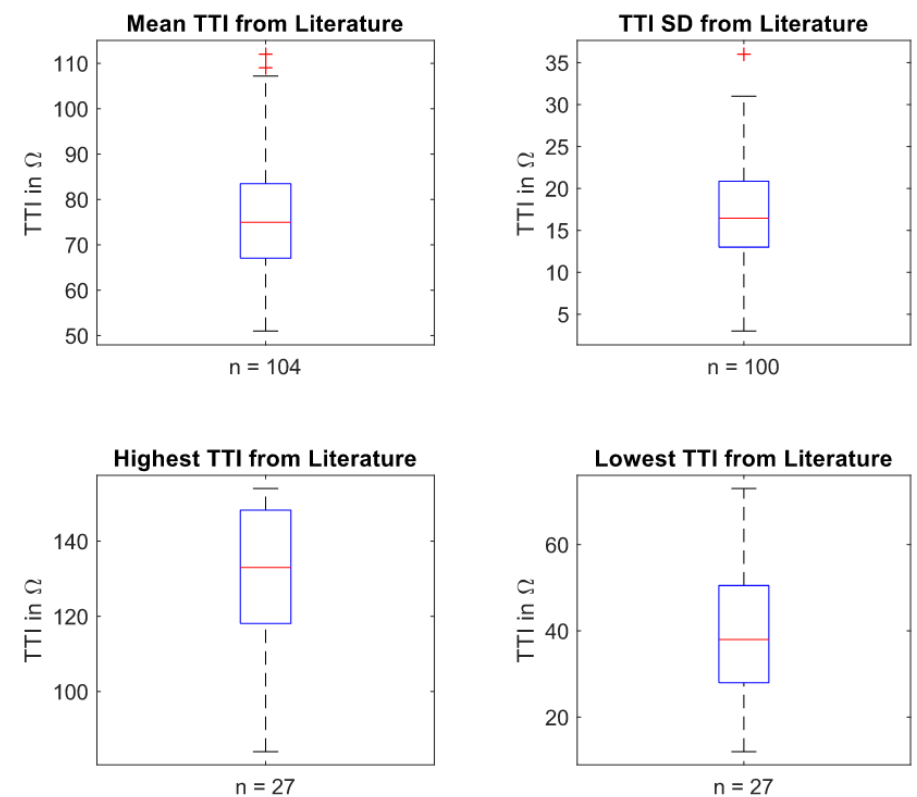
Figure 4. TTI data from Table A1 shown as boxplots. In each subgraph, the number of trials used for box plot analysis is denoted by ‘ n ’ below the graphs. The red line in the box indicates the median value. The upper and lower box boundaries represent the 25th and 75th percentiles, respectively. The most extreme data points are represented by the whiskers, excluding outliers. The latter are marked by a ‘+’